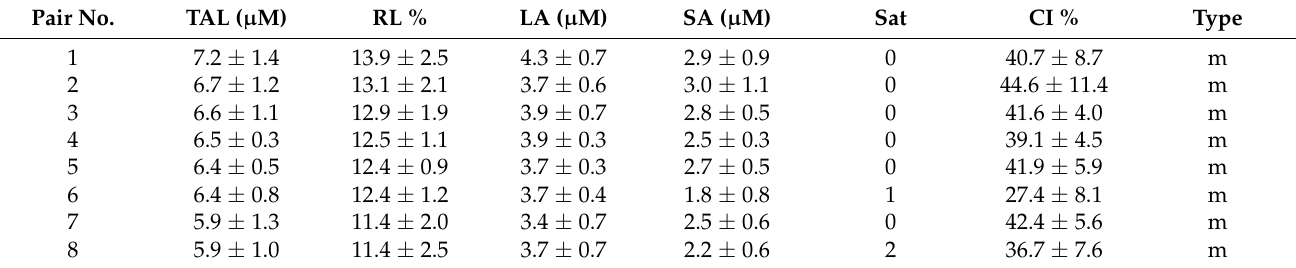
Table 3. Karyo-morphometric parameters of A. caricifolium in µ